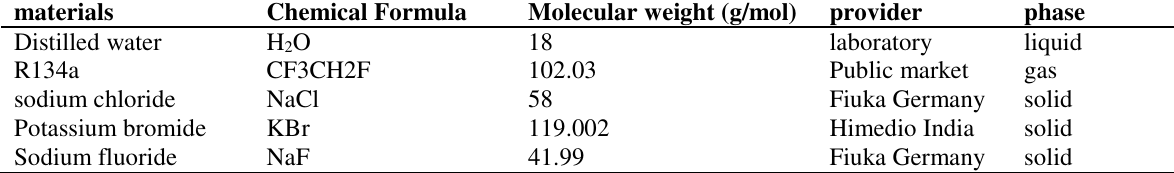
Show the details of different salts, refrigerant and water which are used in this study. materials Chemical Formula